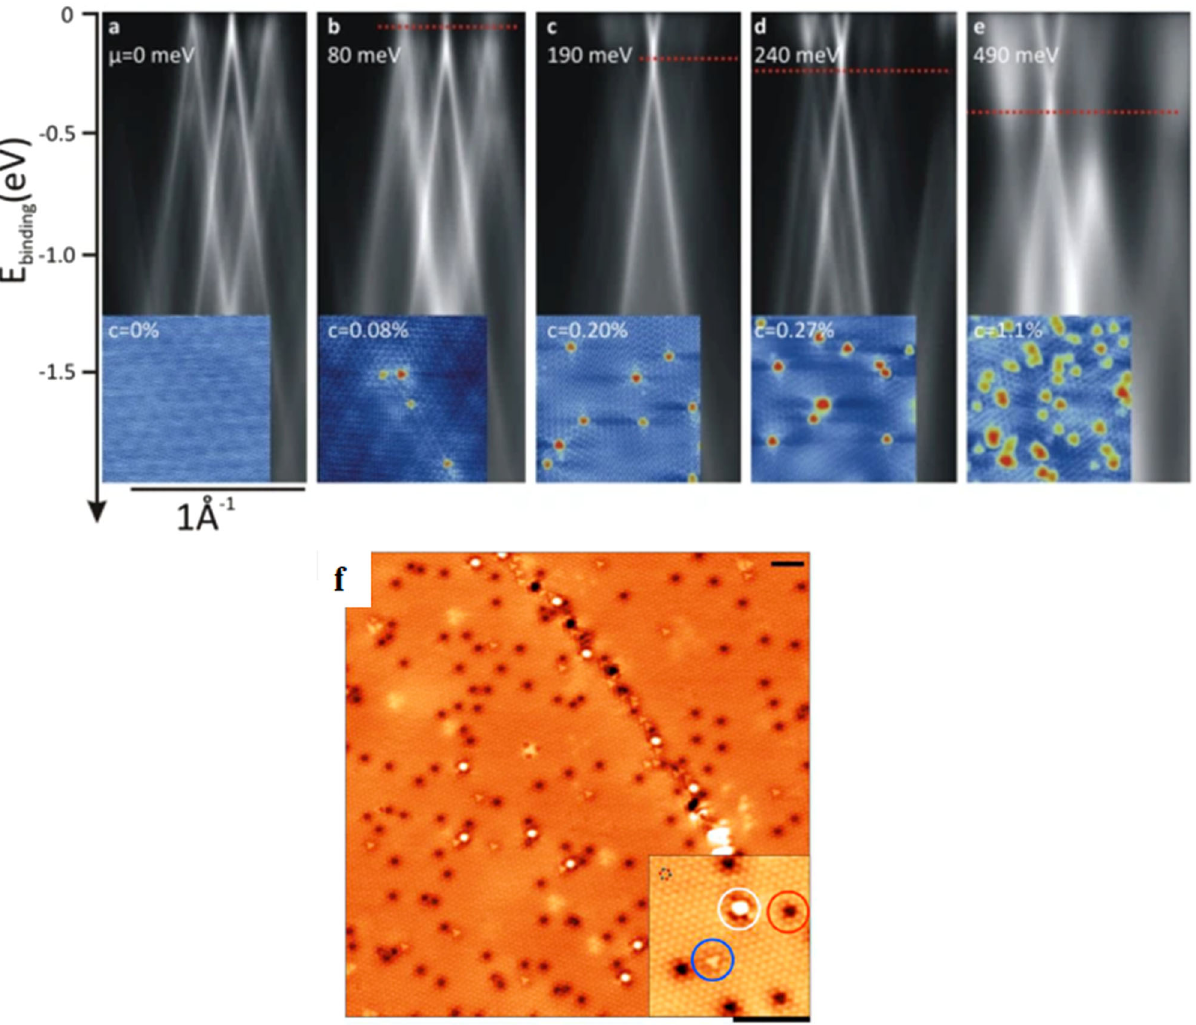
Fig. 7 Scanning tunneling microscopy and angle-resolved photoemission spectroscopy results. a – e ARPES spectra of samples treated for 0, 7.5, 15, 30, and 90 min. The Fermi-level shift ( μ = E F − E D ) is stated on each spectrum. Insets present typical (10 nm × 10 nm) STM images of the corresponding samples. The N dopants appear as red protrusions, and the N concentration ( c ) is given on each image (reproduced from 98 with permission from Springer Nature). f Low-temperature STM image acquired at 77 K. Several surface defects appear. Inset displays the three most abundant types of defects. Scale bars = 2 nm, I = 2.0 nA, V = 0.2 V (reproduced from 76 with permission from (Table 2) 53 . The FETs require proper N-doping locations and low N content to avoid a drastic decrease in electron mobility and open a suitable bandgap, whereas battery applications bene fi t from a speci fi c type of N-doping con fi guration, as detailed below 19,53 .